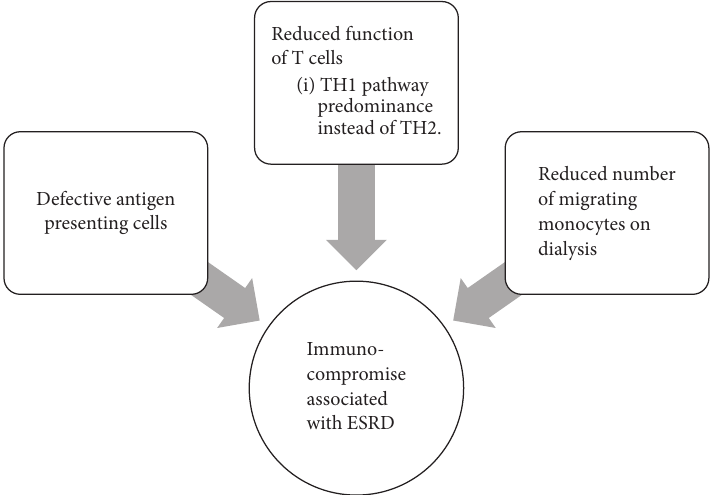
Figure 7: Pathophysiology of impeded immune function in renal failure.